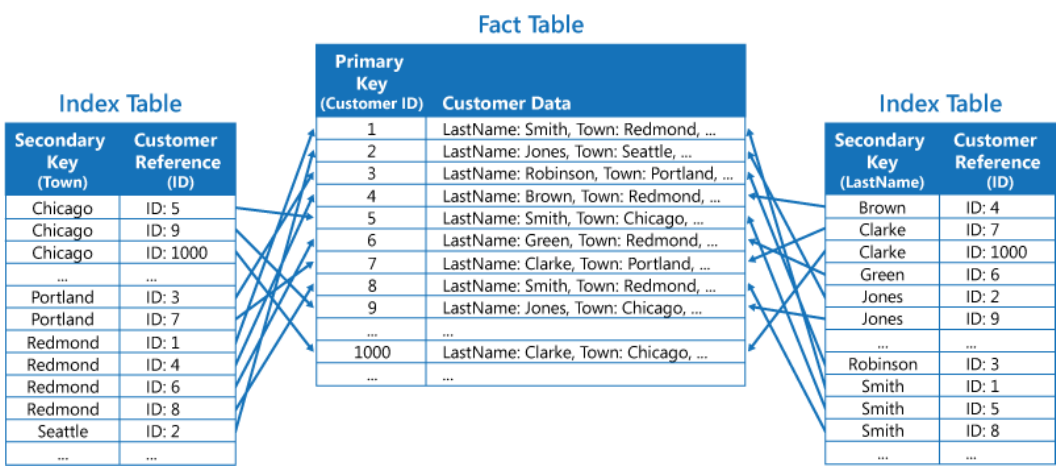
Figure 5. A table linked by a traditional secondary